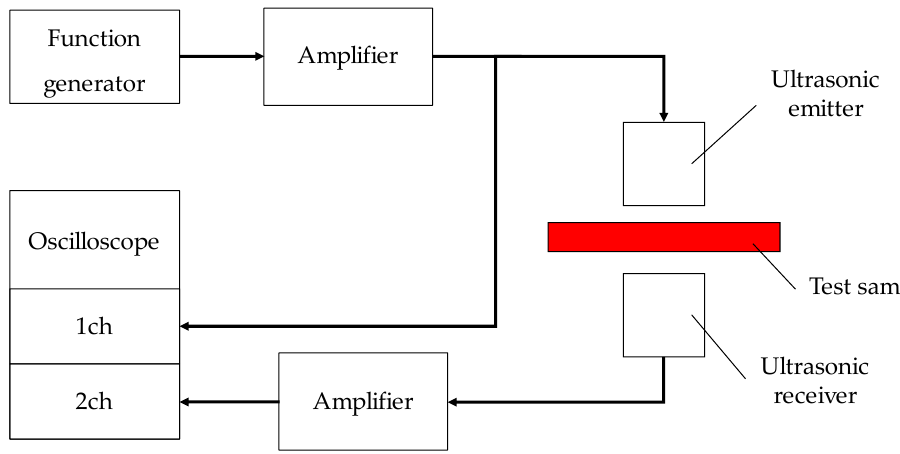
Figure 3. Configuration diagram of measurement of tortuosity.